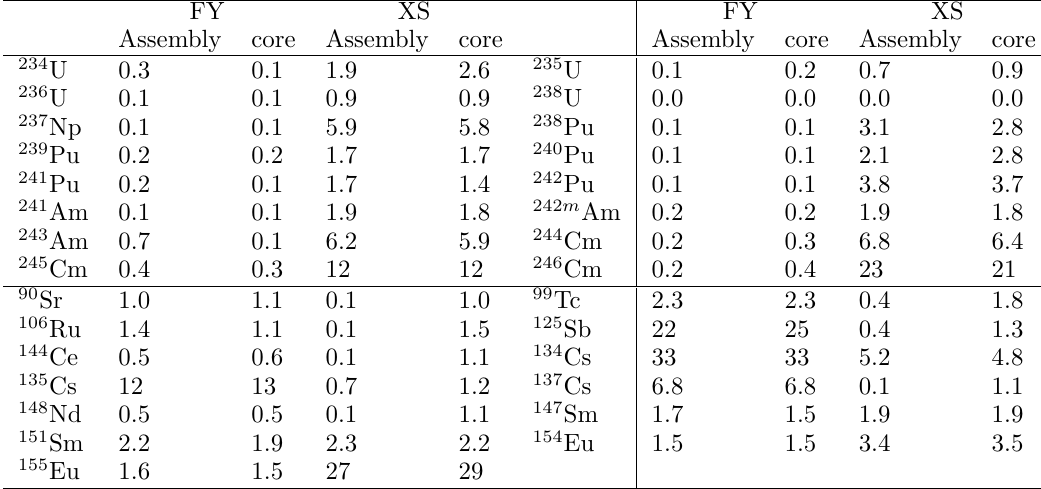
Table B.8. Comparison of uncertainties (in %) from nuclear data FY and XS between the assembly (2D) and full core (3D) models. Uncertainties are given in % (1 σ ). The term FY corresponds to fission yields, and XS to the rest of nuclear data. Values are provided at the time of